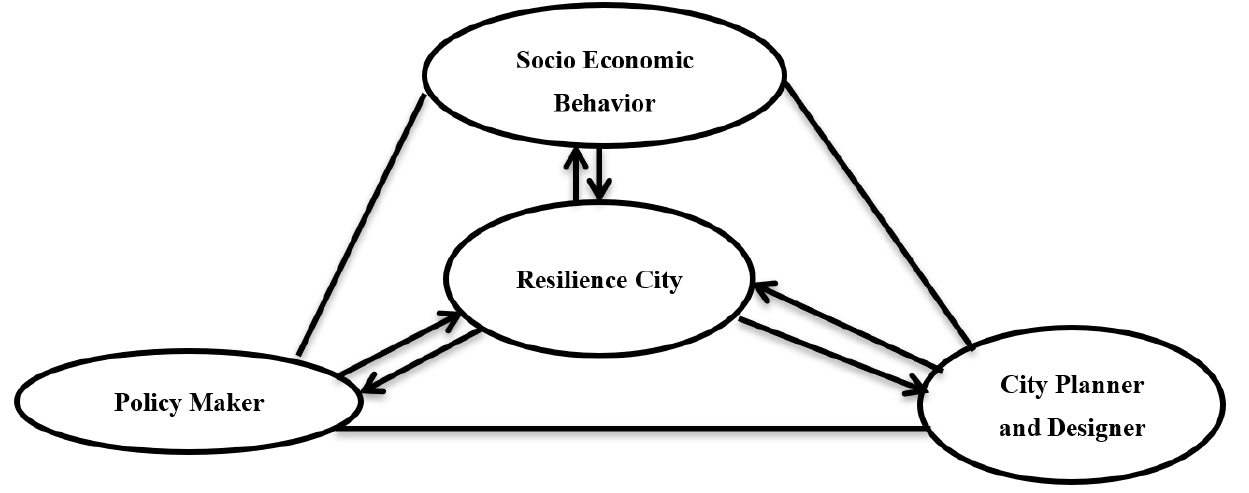
Figure 6. Ways of integration to promote city resilience , modified from Mengistu et al. [15].